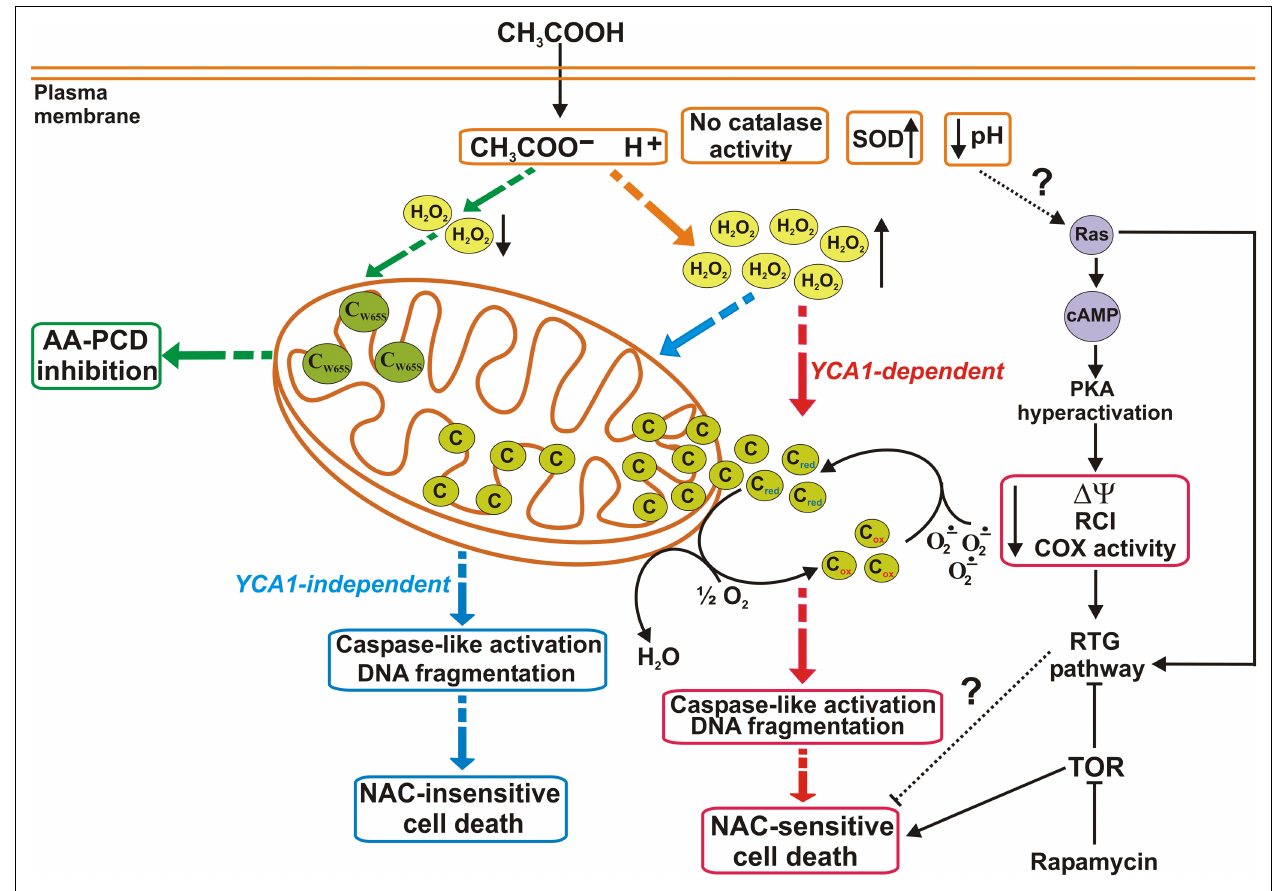
FIGURE 1 | Cytochrome c and mitochondrial dysfunction inAA-PCD pathways. At extracellular acidic pH values acetic acid enters yeast cells and dissociates into acetate and protons causing intracellular acidification. In NAC-sensitive AA-PCD (red dashed arrows) hydrogen peroxide (H 2 O 2 ) accumulates early, superoxide dismutase (SOD) activity increases, while catalase activity is undetectable; cyt c is released to the cytosol in a YCA1-dependent manner as a functional protein, acting as an electron donor (c red ) to the electron transport chain and as a superoxide anion (O 2 − . ) scavenger; in a late phase, mitochondrial functions progressively decline, as revealed by a decrease in mitochondrial membrane potential ( (cid:2)(cid:3) ), respiratory control index (RCI), and cyt c oxidase (COX) activity. Caspase-like activity increases and DNA fragmentation occurs.The NAC-insensitive (blue dashed